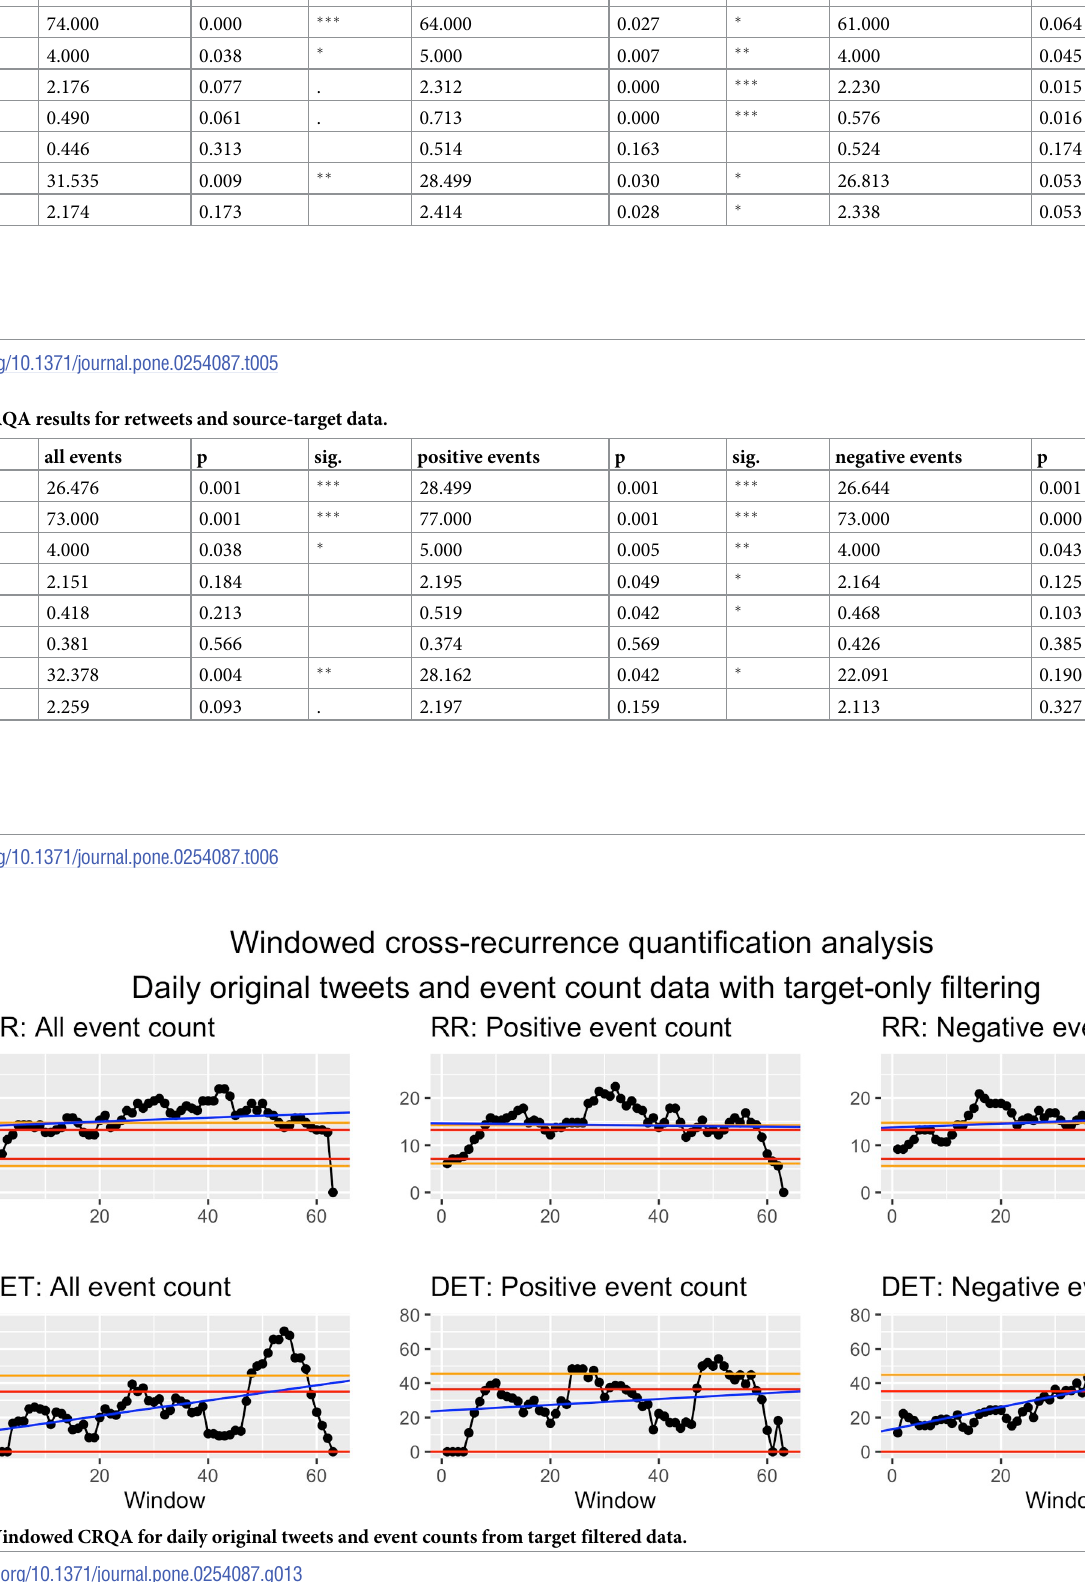
Table 5. CRQA results for retweets and target-only data. metric